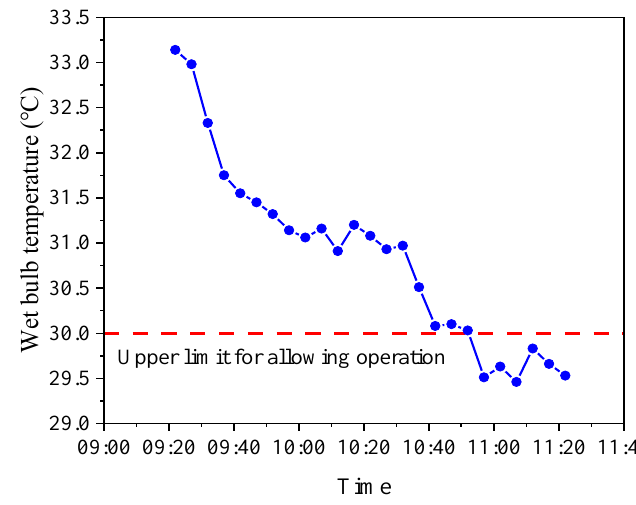
Figure 6. Change in wet bulb temperature at measuring point P42.